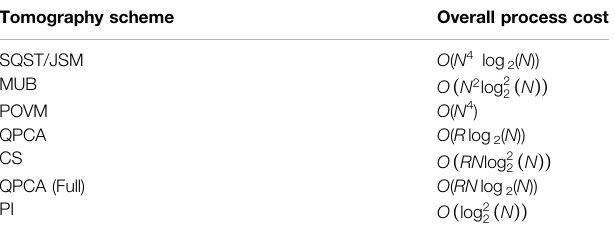
TABLE 2 | Resource Analysis for schemes oftomography ofquantum states. The schemes presented consists of Standard Quantum State Tomography (SQST), Joint Separable Measurements (JSM), Mutual Unbiased Measurements (MUB), Positive Operator Valued Measurements (POVM), Quantum Principal Component Analysis (QPCA), Compressed-Sensing (CS) and the PermutationallyInvariantQuantumTomography(PI)scheme.NotethatQPCA process can be used to reconstruct large eigenvalues of the Hilbert space, as well as the full density matrix (QPCA